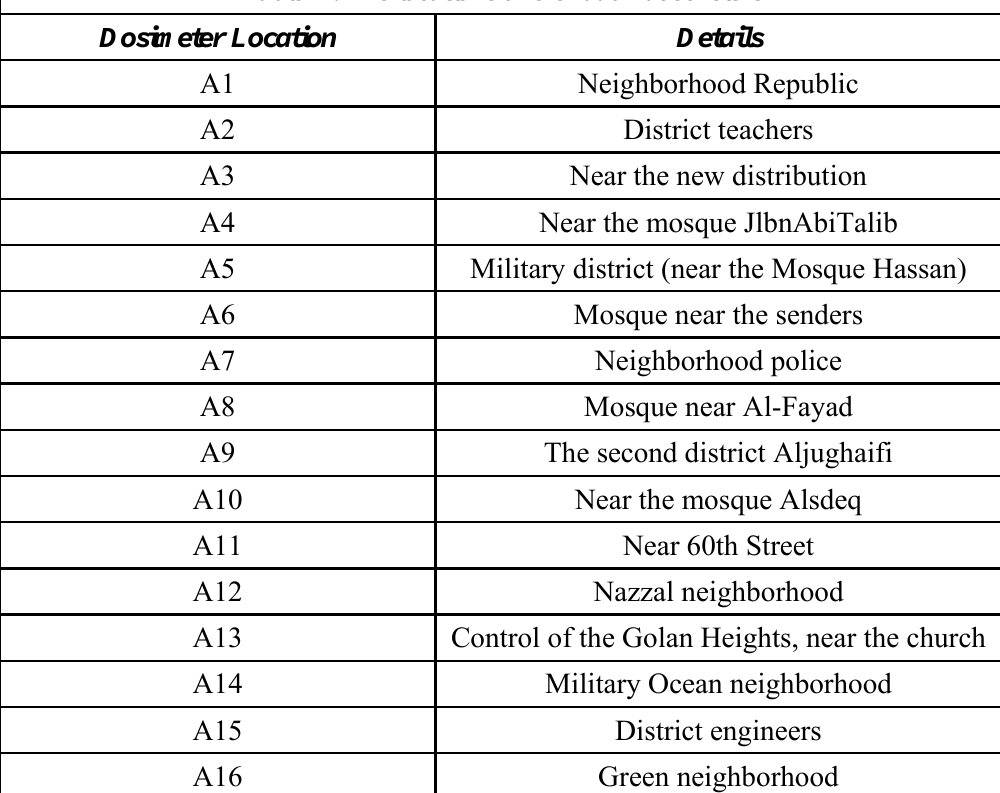
Table 1 : The locations of the radon